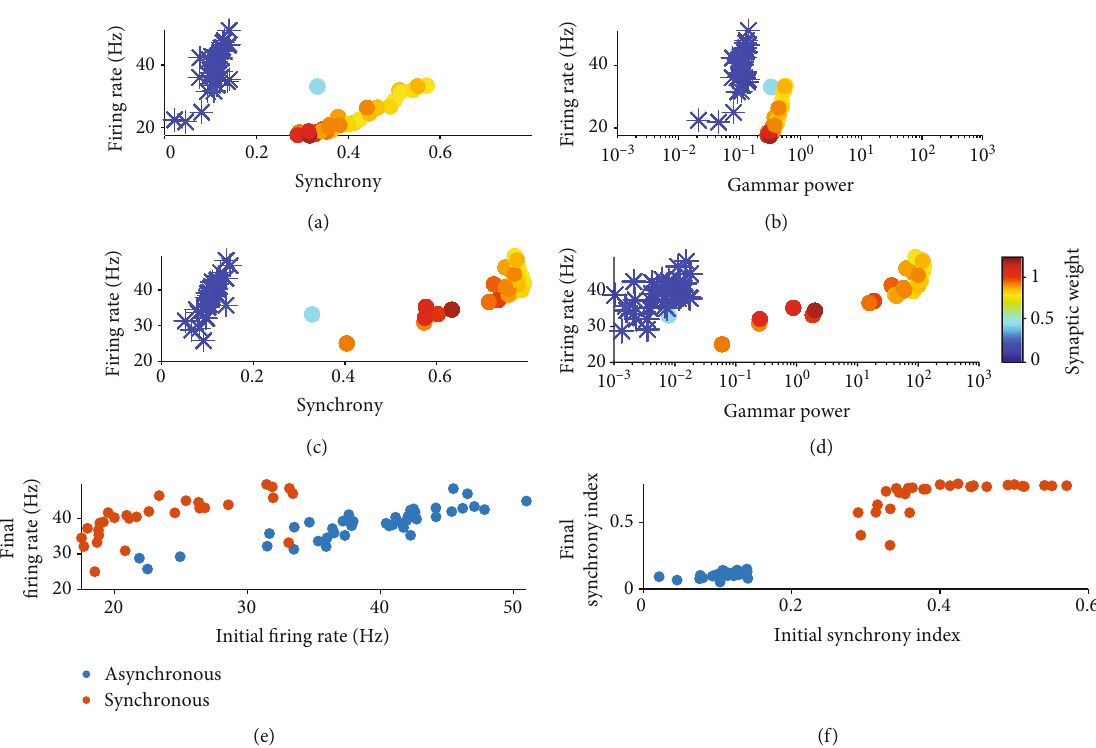
Figure 6: The relationship between synaptic potentiation and network dynamics in circuit with plasticity. (a, b) The relationship between the fi nal stable synaptic weight (represented by color) and initial fi ring rates and gamma power. (c, d) The relationship between the fi nal stable synaptic weight and fi nal fi ring rates and gamma power. In general, there is a positive correlation between the gamma power/synchrony index and the stable synaptic weight. Stars represent the results in asynchronous states whereas dots represent results in synchronous and moderate synchronous states. (e, f) The relationship between initial and fi nal fi ring rate and synchrony index, respectively. In (a – f), parameters used are τ E = 3, 4, 5 ⋯ 10,20,30 ⋯ 90ms , τ I = 8ms , As = 2, 2 : 5, 3, 3 : 5 d d